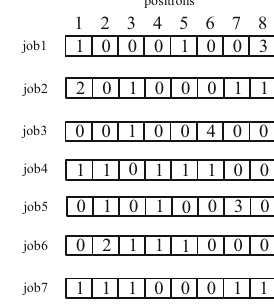
The relative percentage increase (RPI) is used as a perfor- mance measure and is calculated as